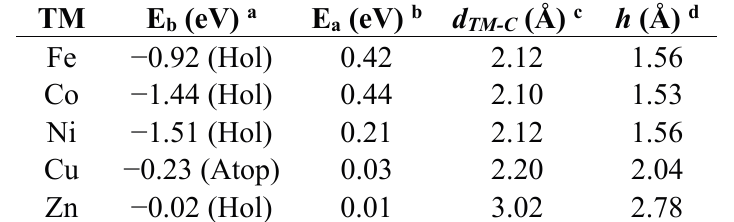
Table 1. The most plausible structures, E ad and diffusion barriers of TM atoms deposition on